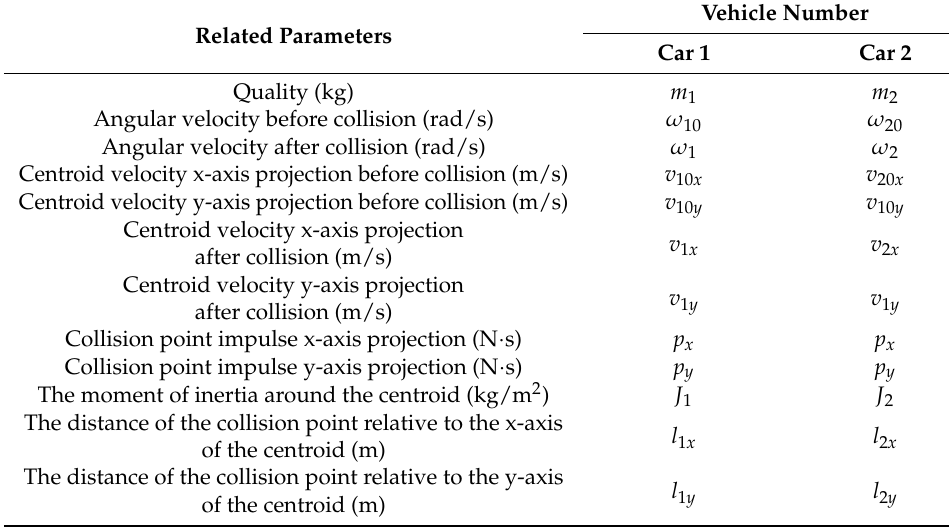
Table 1. Parameters of the general two-dimensional point collision dynamic